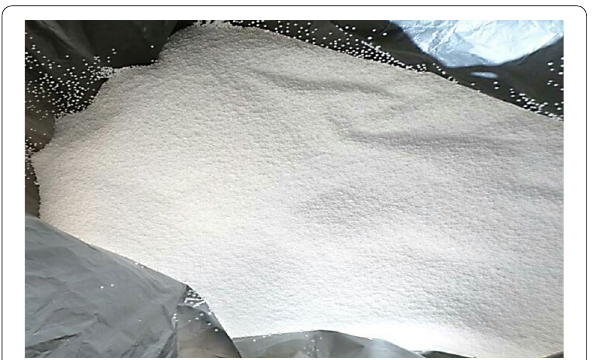
Fig. 2 Polystyrene beads.